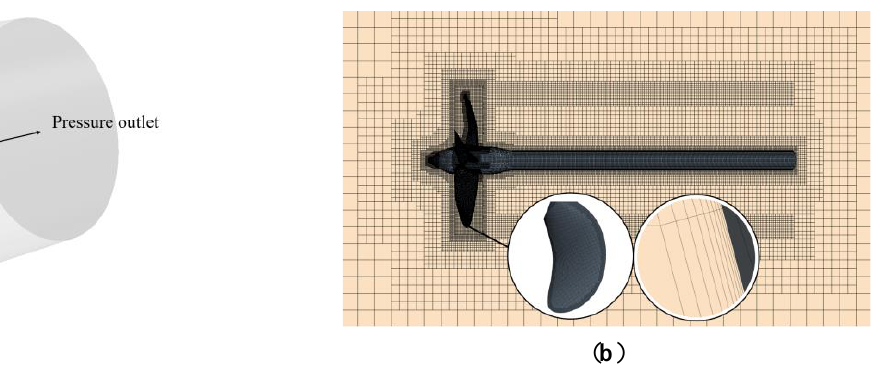
Figure 4. Calculation domain ( a ) and the mesh encryption ( b ).